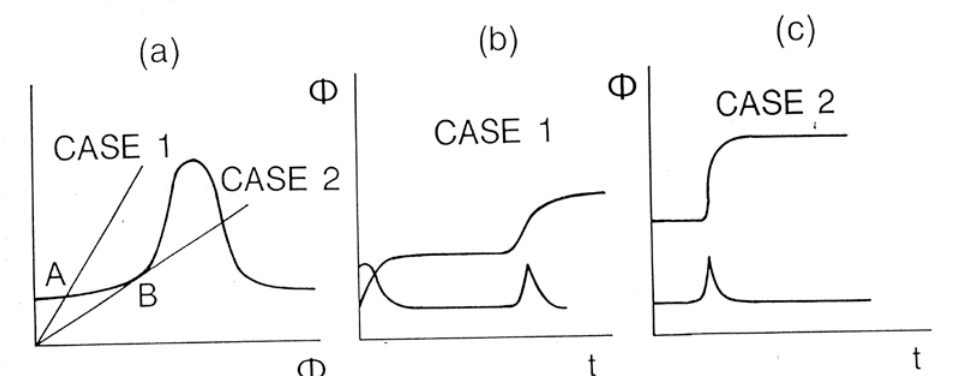
Fig.3: (a) The intersection of the phase with the Airy function. When the holding phase is far away from the switch point, the output characteristic will start with nonlinear characteristic and long slowing down, (b) when the holding phase becomes very close to the switch point, the fast switching characteristics will occur (c)